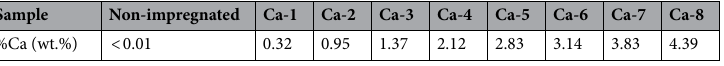
Table 1. Calcium concentration in the